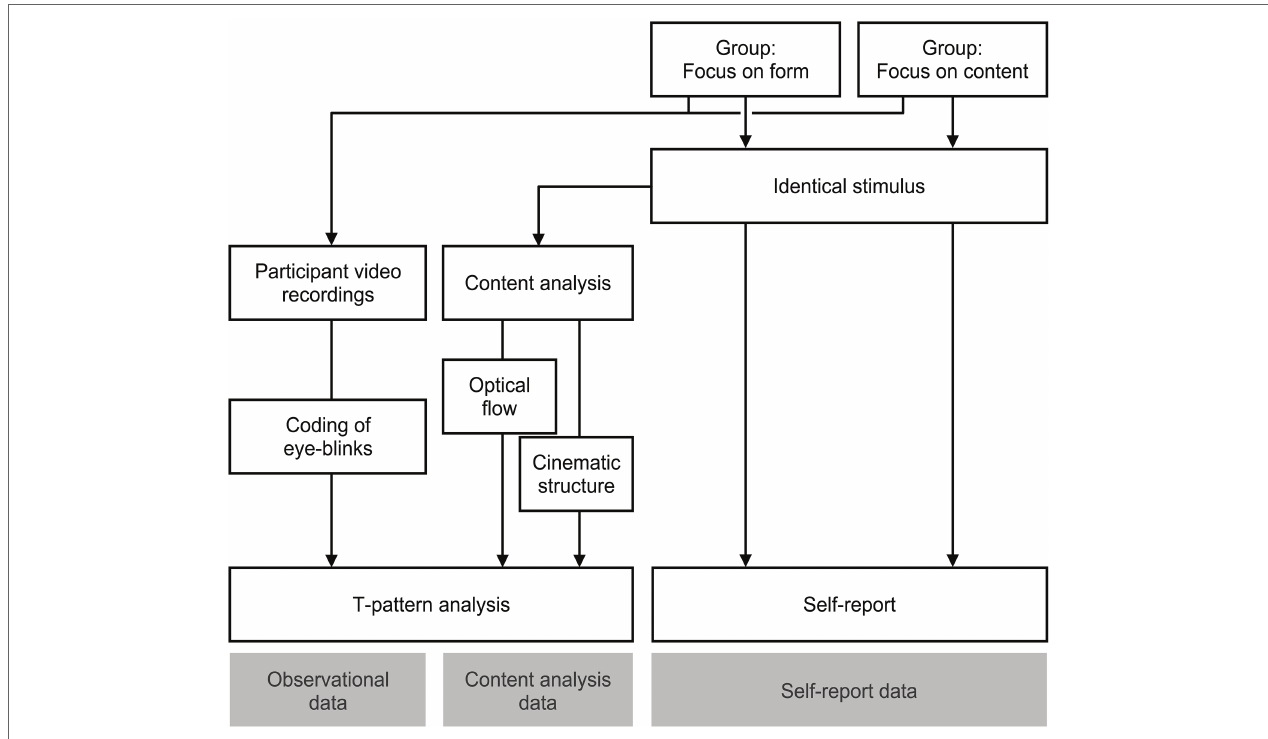
FIGURE 1 | Schematic overview of the experimental and analytical procedures in the present study’s mixed methods